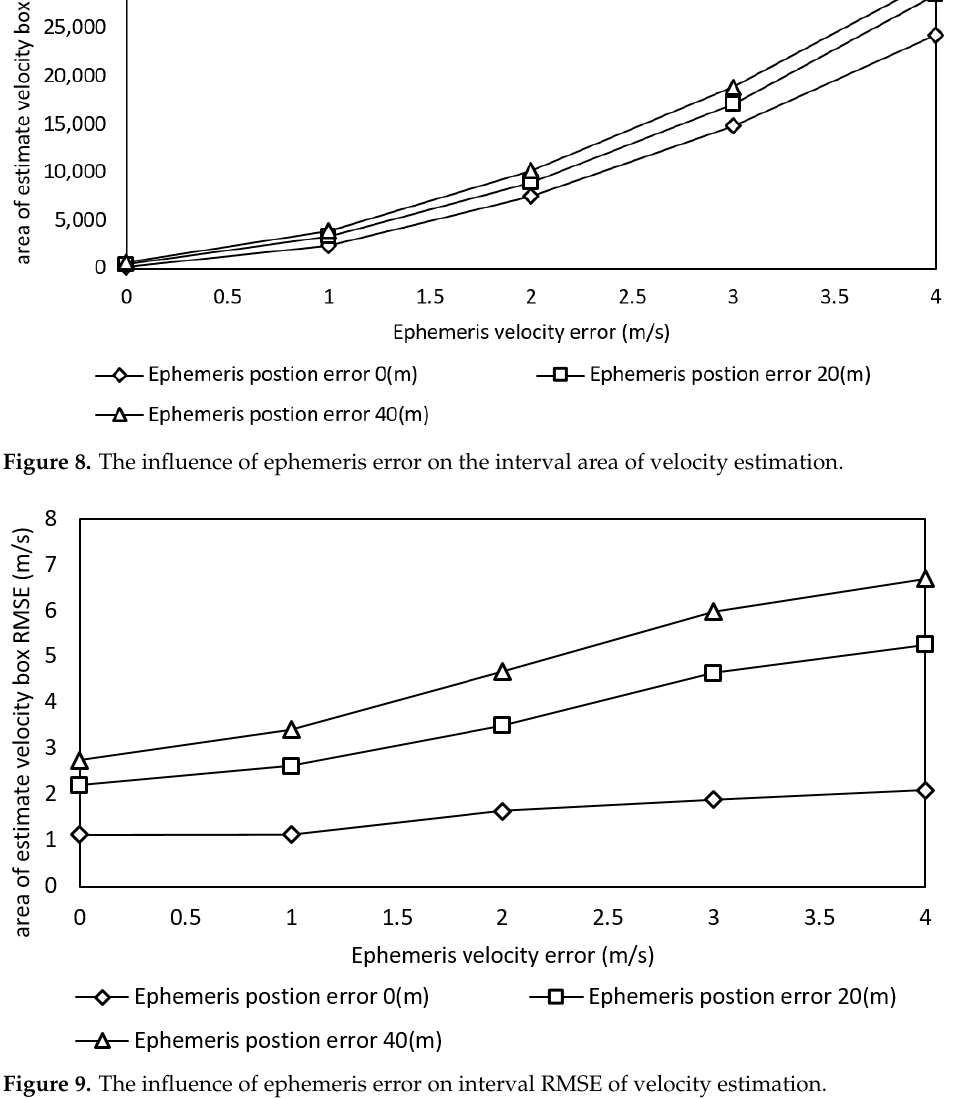
Figure 9. The influence of ephemeris error on interval RMSE of velocity estimation.